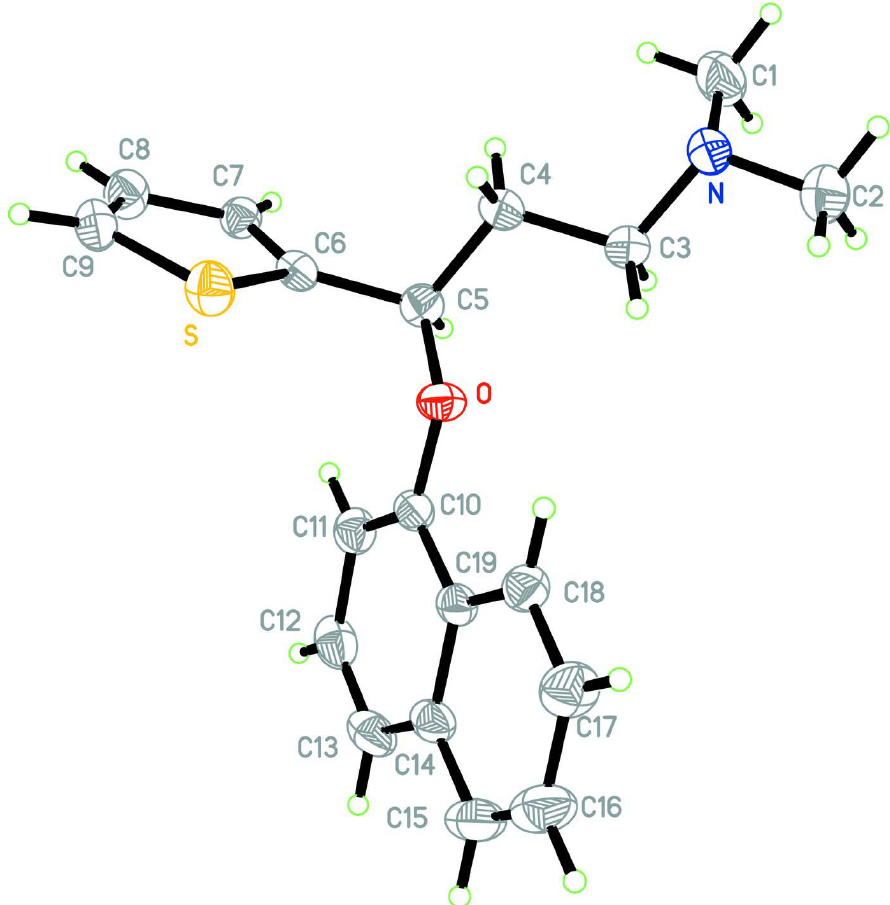
Figure 1 The structure of (I). Displacement ellipsoids are drawn at the 30% probability